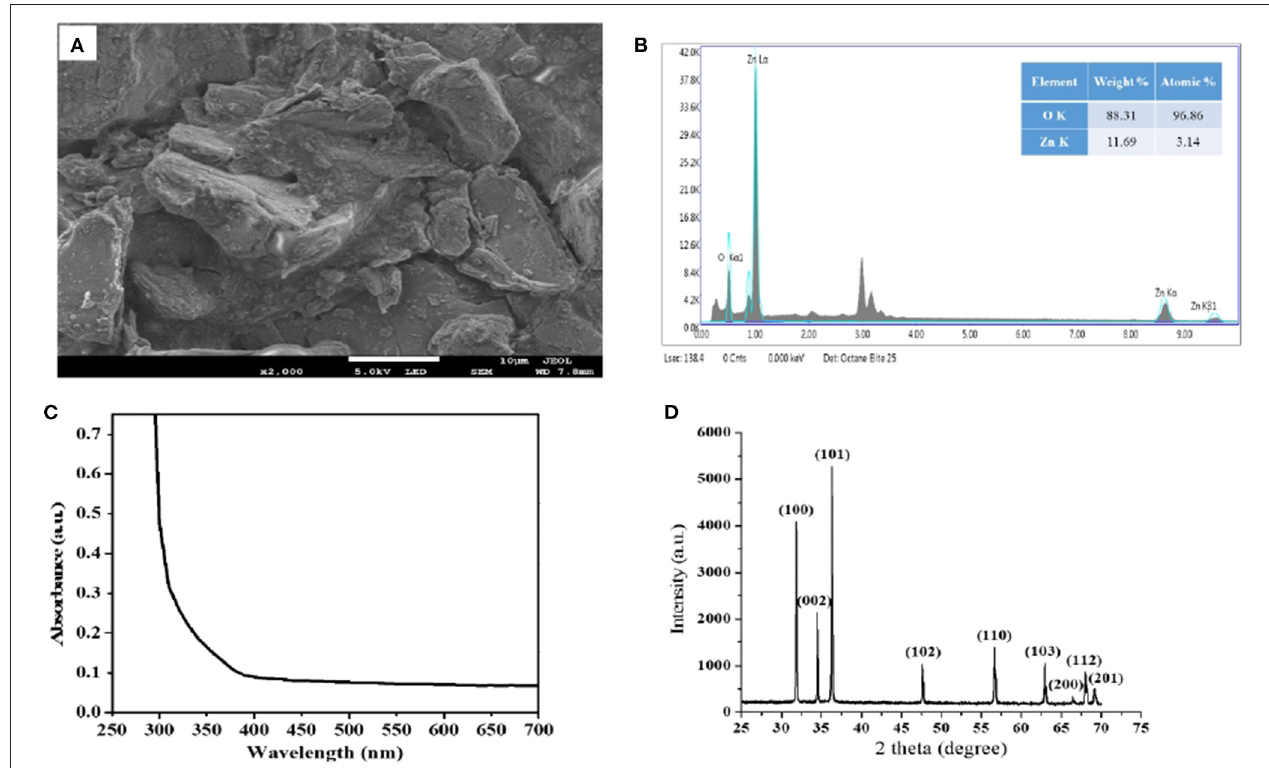
FIGURE 2 | (A) SEM image of MO -stabilized ZnO NPs exhibiting nano-granules accumulated on the bulk, (B) EDX map clearly showing traces of Zn and oxygen elements, (C) corresponding UV-Vis absorption spectrum and (D) XRD pattern of MO -stabilized ZnO NPs.